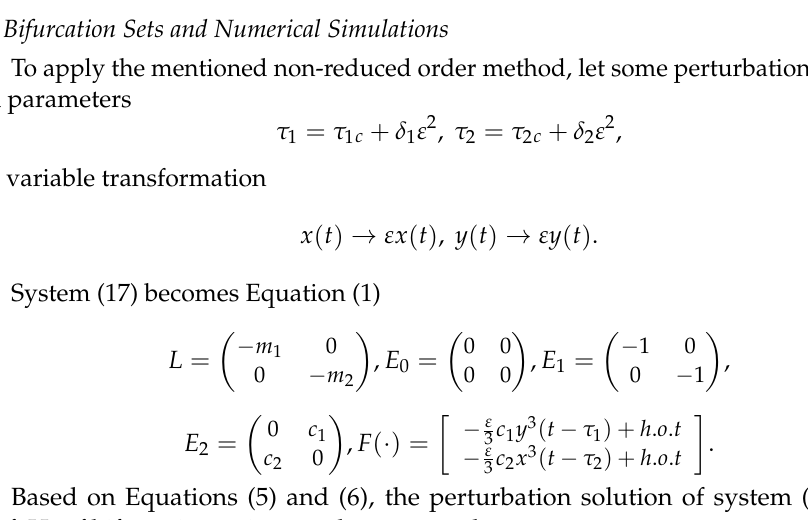
Figure 1. The eigenvalues of characteristic equation for networks (17).